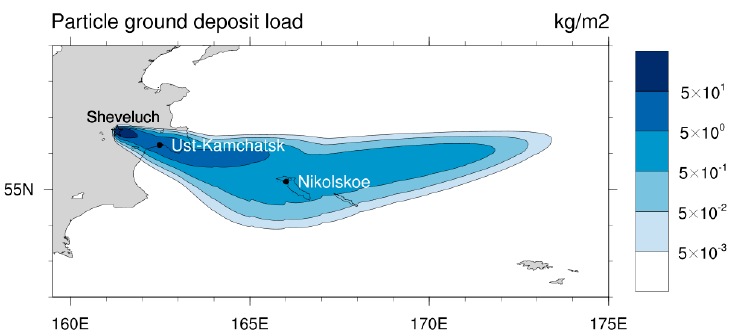
Figure 16. The overall weight of the Sheveluch ash as of 07:07 UTC, 12 November 1964.